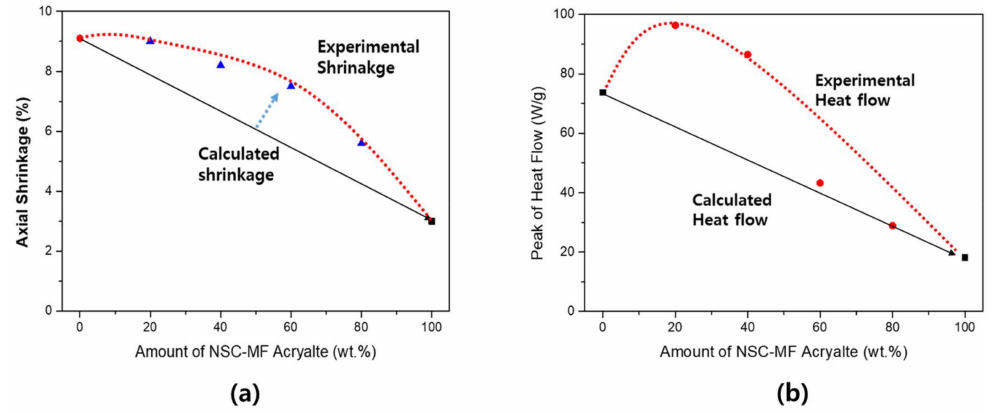
Figure 13. Blended system of NSC-MF acrylate and TMPTA: ( a ) shrinkage ratio; and ( b ) peak of heat flow.